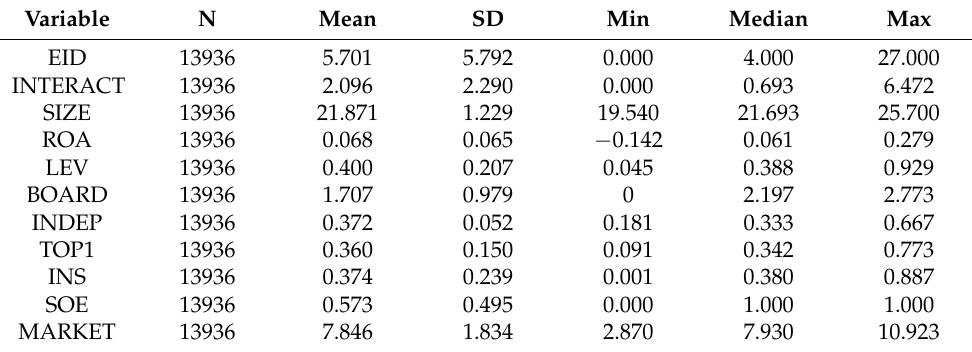
Table 2. Descriptive statistics.